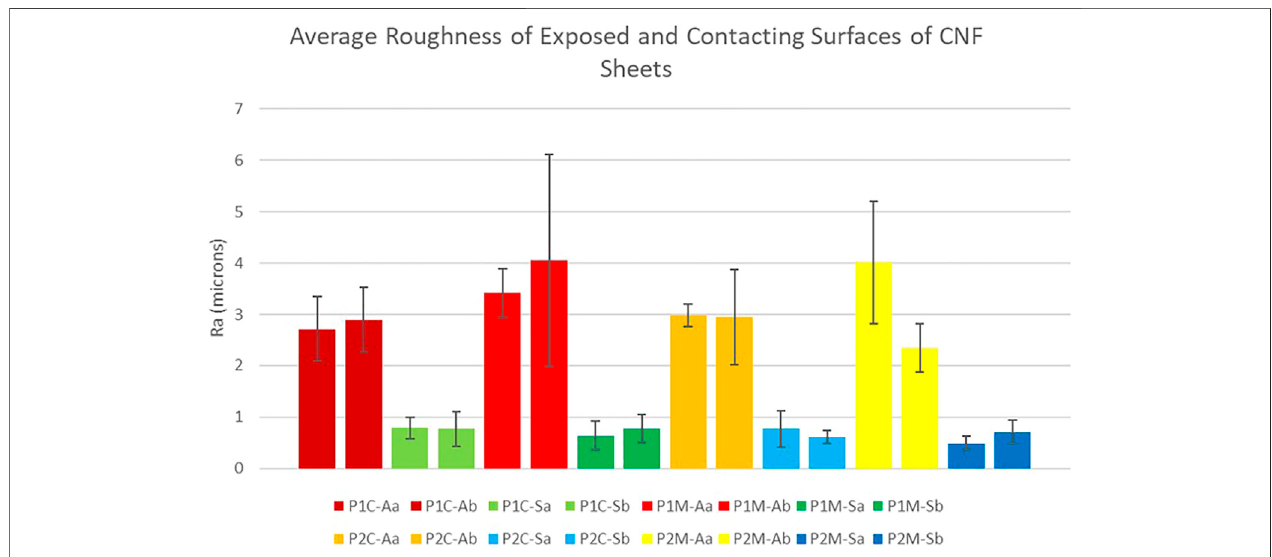
FIGURE 7 | Surface Roughness Measurement Results. Average surface roughness (Ra) of two distinct sheet sides. P1-plate 1, P2-plate 2, C-cross machine direction, M-machine direction, A-air exposed, S-steel contacting, a-sample one, and b-sample two.